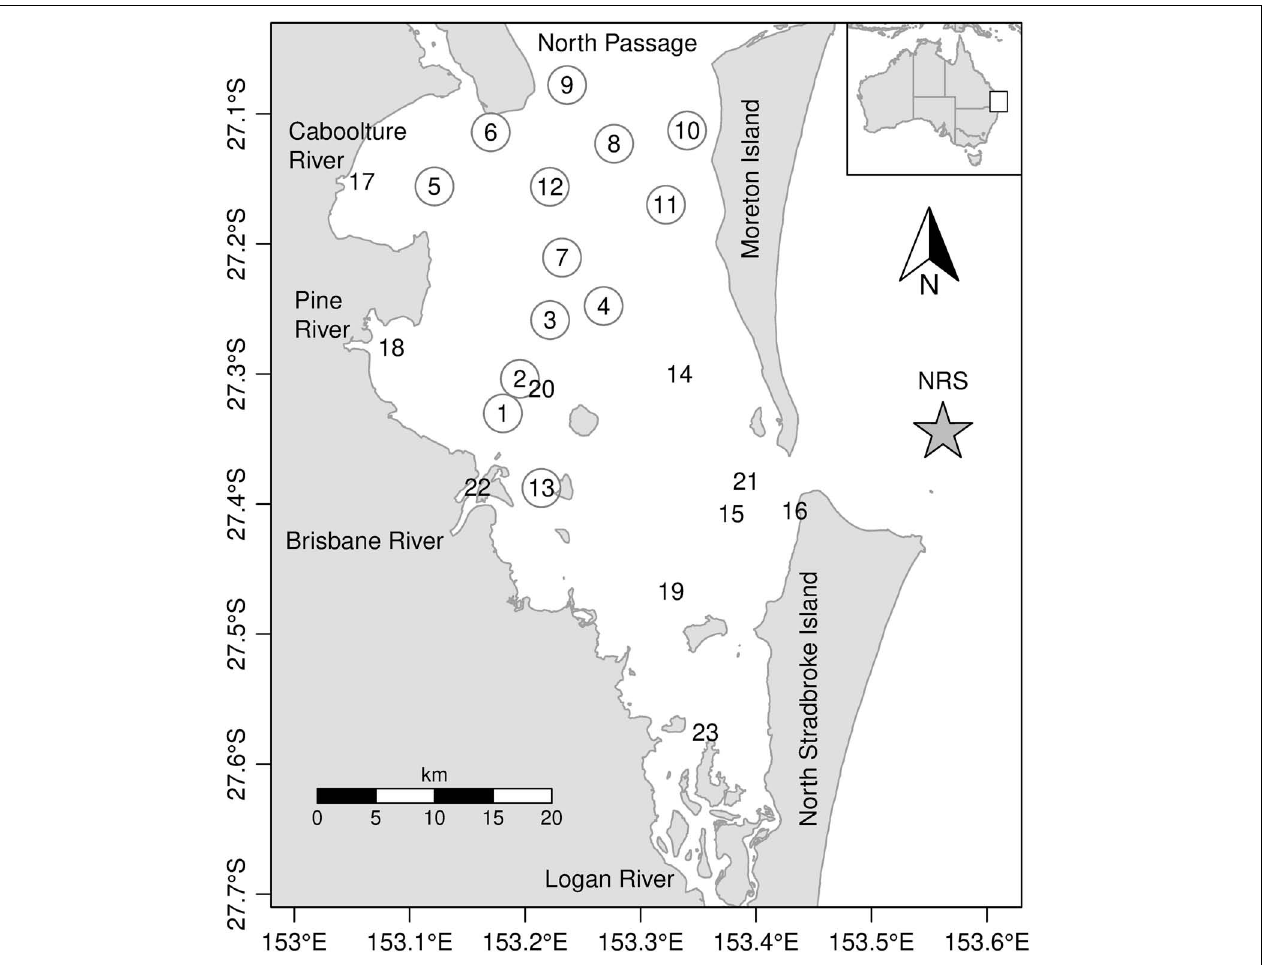
FIGURE 1 | Map of station locations in Moreton Bay. Inset indicates location of Moreton Bay in Australia. Circled numbers indicate core stations sampled every trip and non-circled numbers are stations sampled occasionally. The star indicates the location of the IMOS National Reference Site